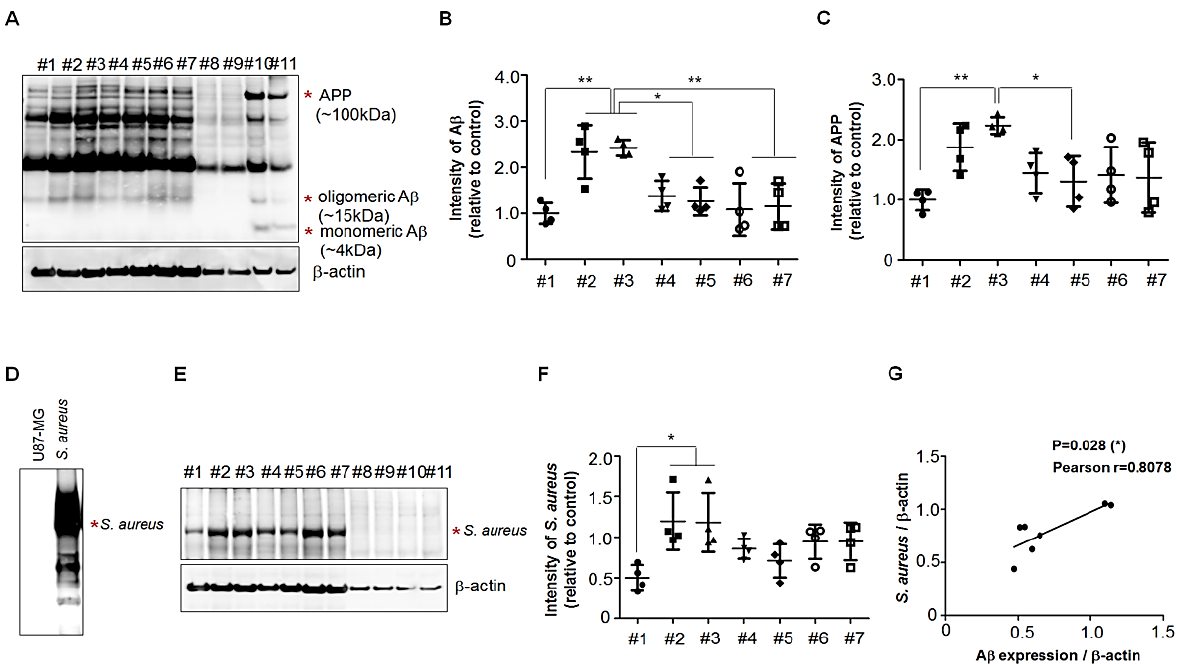
Figure 3. Expression of A β -specific 6E10 immunoreactive proteins in human palatine-tonsil speci- mens. ( A ) Western blots of SDS − PAGE gels of human palatine-tonsil tissue extracts using